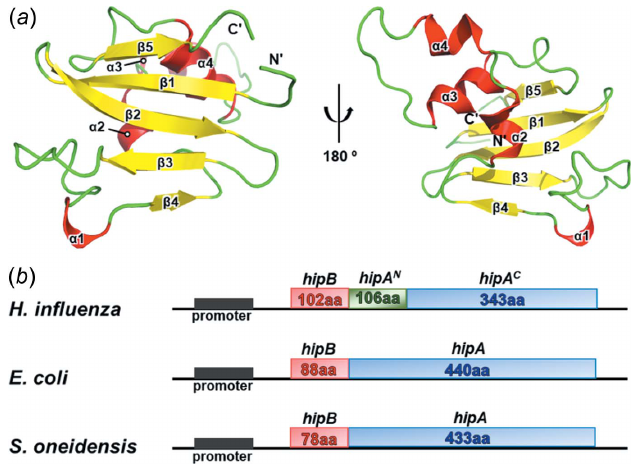
Figure 1 The overall structure of the H. influenzae HipA N and hipBA genome maps. ( a ) 180 (cid:3) rotated views of H. influenzae HipA N . (cid:3) -Helices, (cid:2) -strands and loops are coloured red, yellow and green, respectively. ( b ) Schematic diagram showing a comparison of the hipBA operons of H. influenzae , E. coli and S. oneidensis